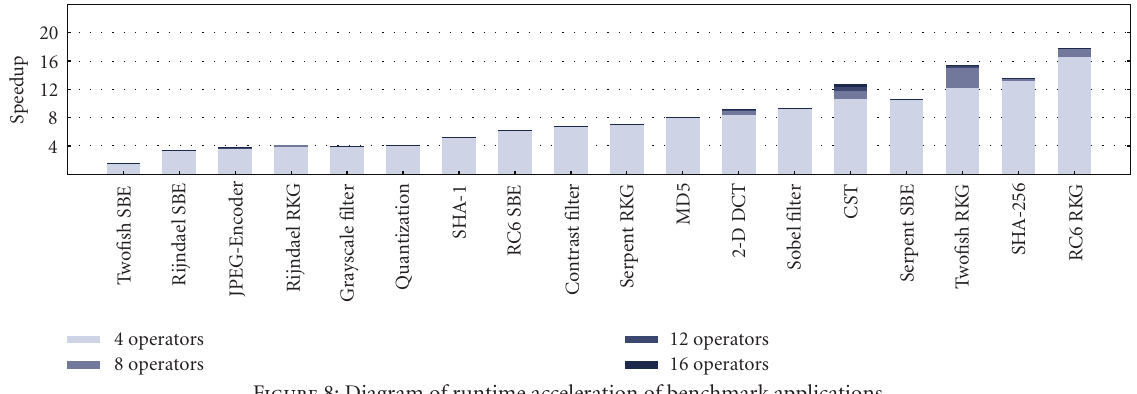
Figure 8: Diagram of runtime acceleration of benchmark applications.